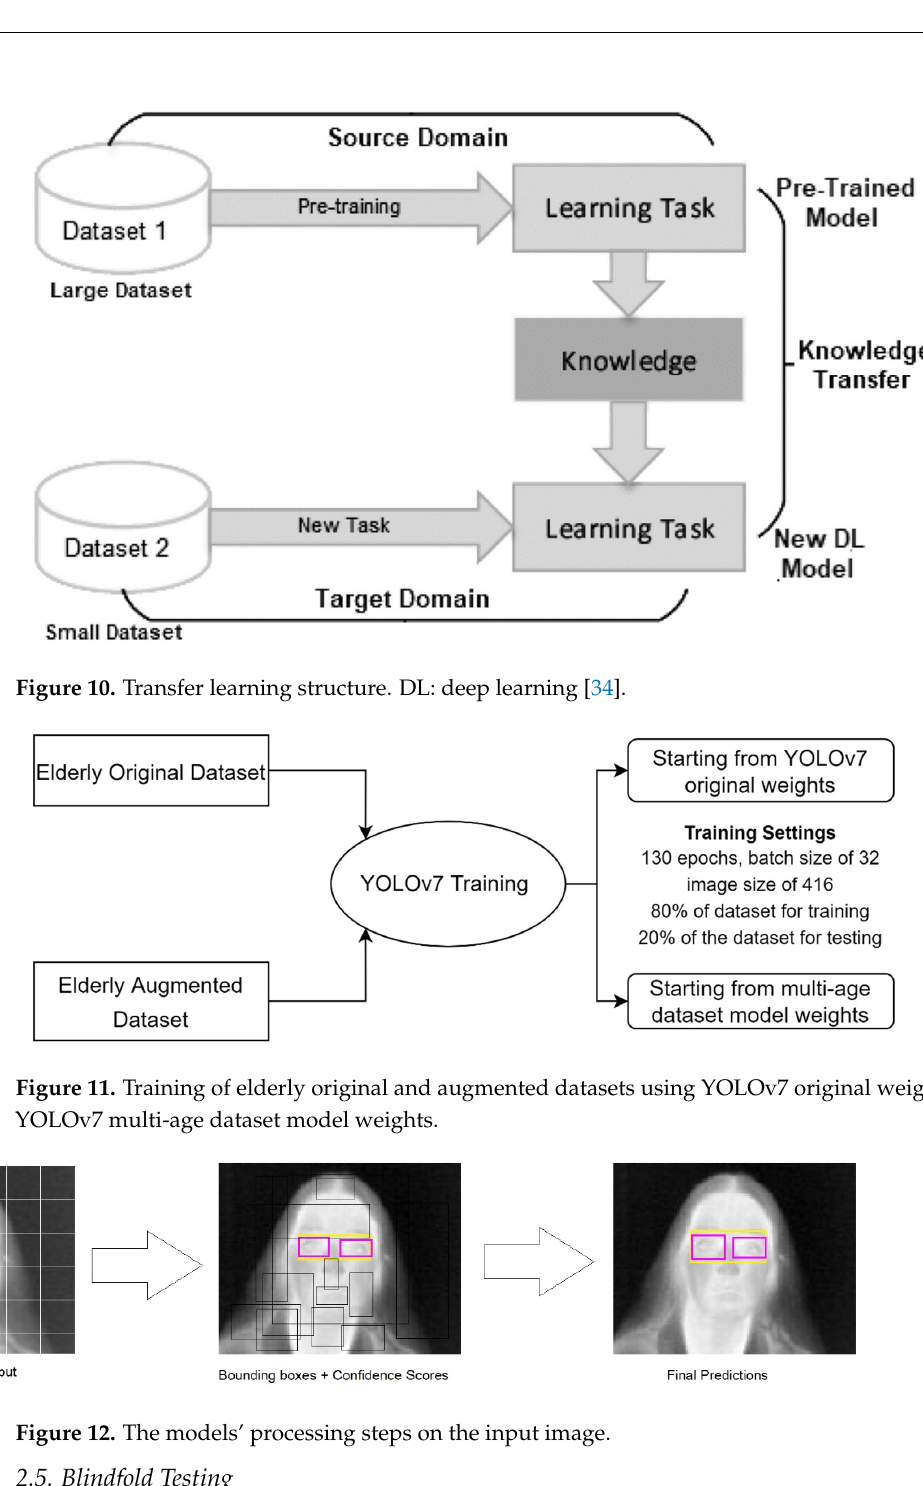
Figure 12. The models’ processing steps on the input image.